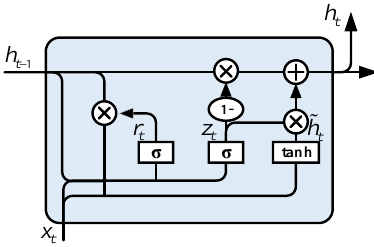
Figure 1. The architecture of GRU unit.